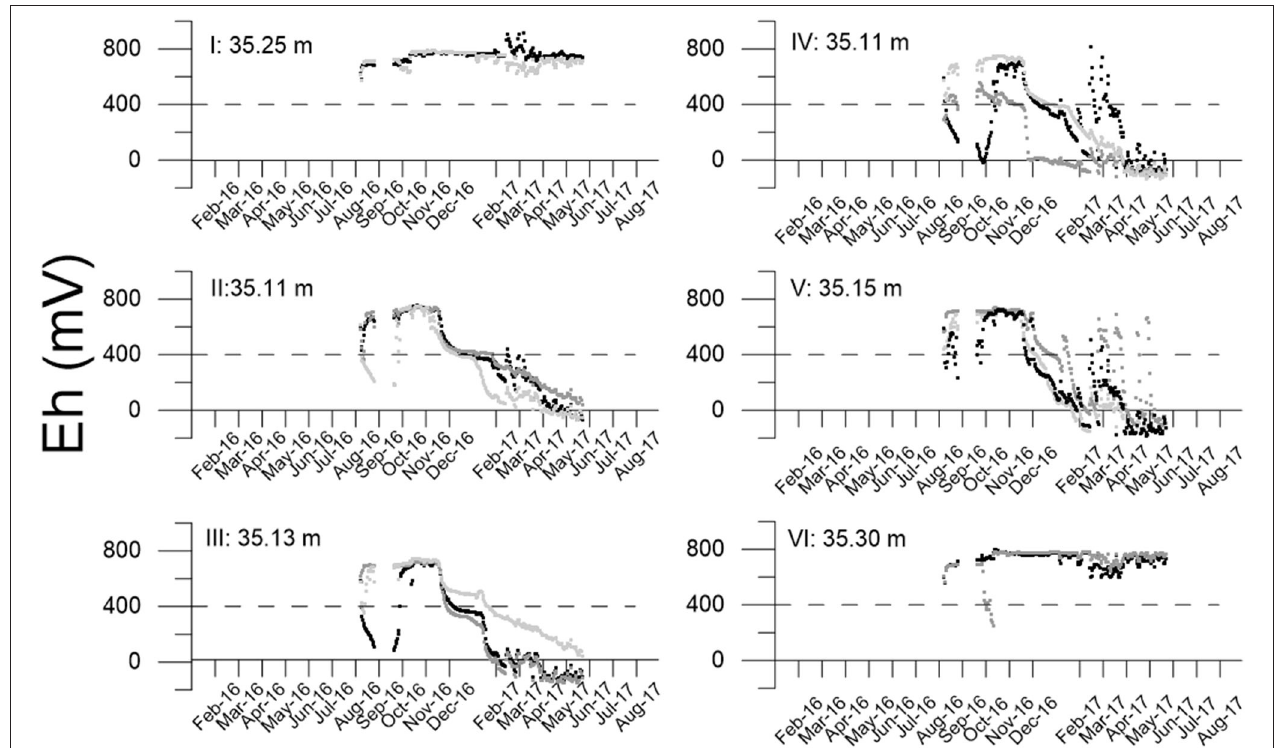
FIGURE 4 | Redox measurements in location A, the fen. Individual sensor location marked, m a.s.l. and in Figure 1 . Dotted line – 400mV reference for aerobic/anaerobic soil environment.